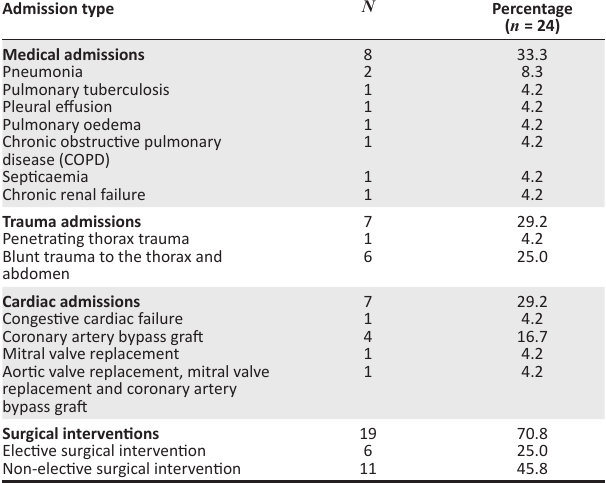
TABLE 3: Reasons for admission and types of surgery recorded for study participants.